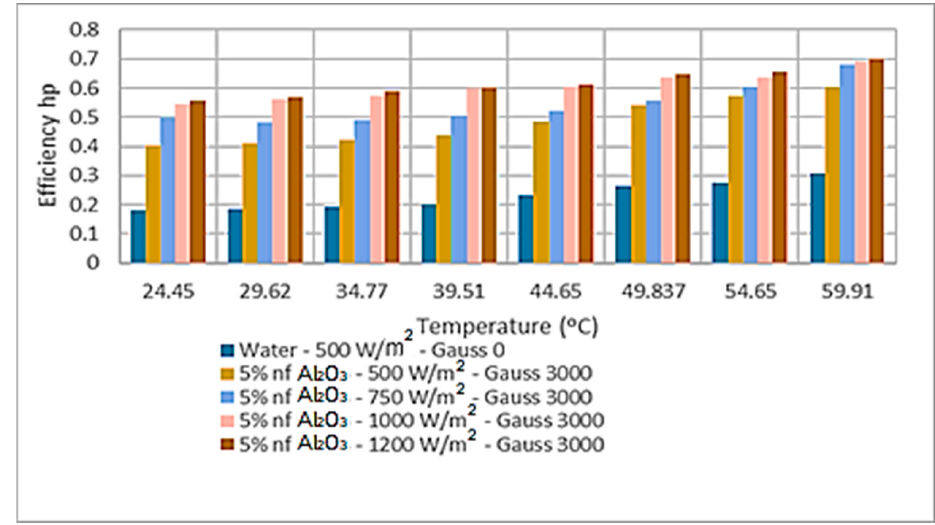
Figure 18. Heat pipe thermal energy efficiency generated by PV-Th solar panels with different solar radiations.